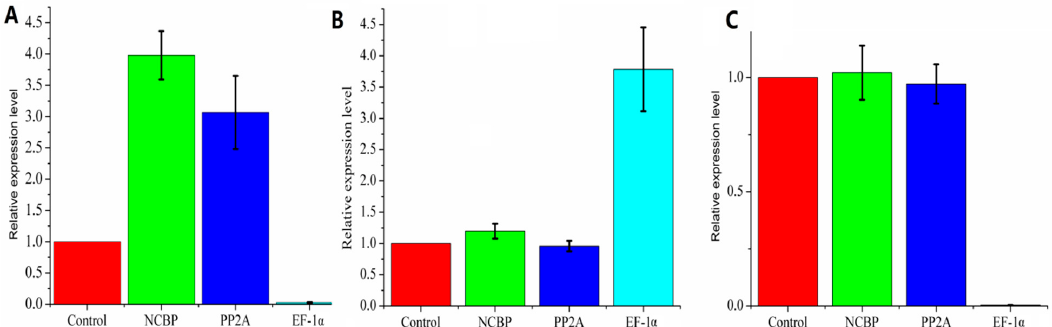
Figure 5. Validation of the reference genes. Relative expression level of 1-aminocyclopropane-1- carboxylate oxidase (ACO) was normalized using NCBP, protein phosphatase 2A (PP2A), and elongation factor 1-alpha (EF-1 α ), under different treatments. ( A ) Treated with NaCl. ( B ) Treated with MeJA. ( C ) Treated with CuSO 4 . Data are displayed as mean ± SEM ( n = 3).